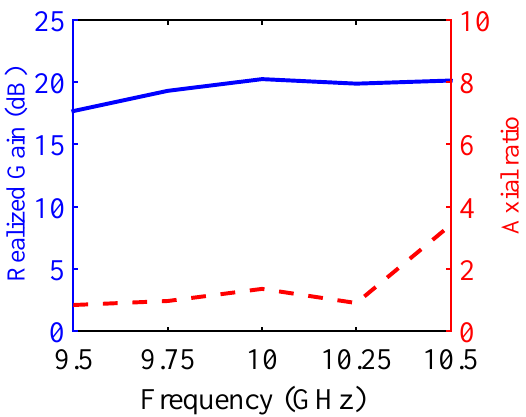
Figure 10: Simulated realized gain and axial ratio of the proposed HPM reflectarray antenna as a function of fre-